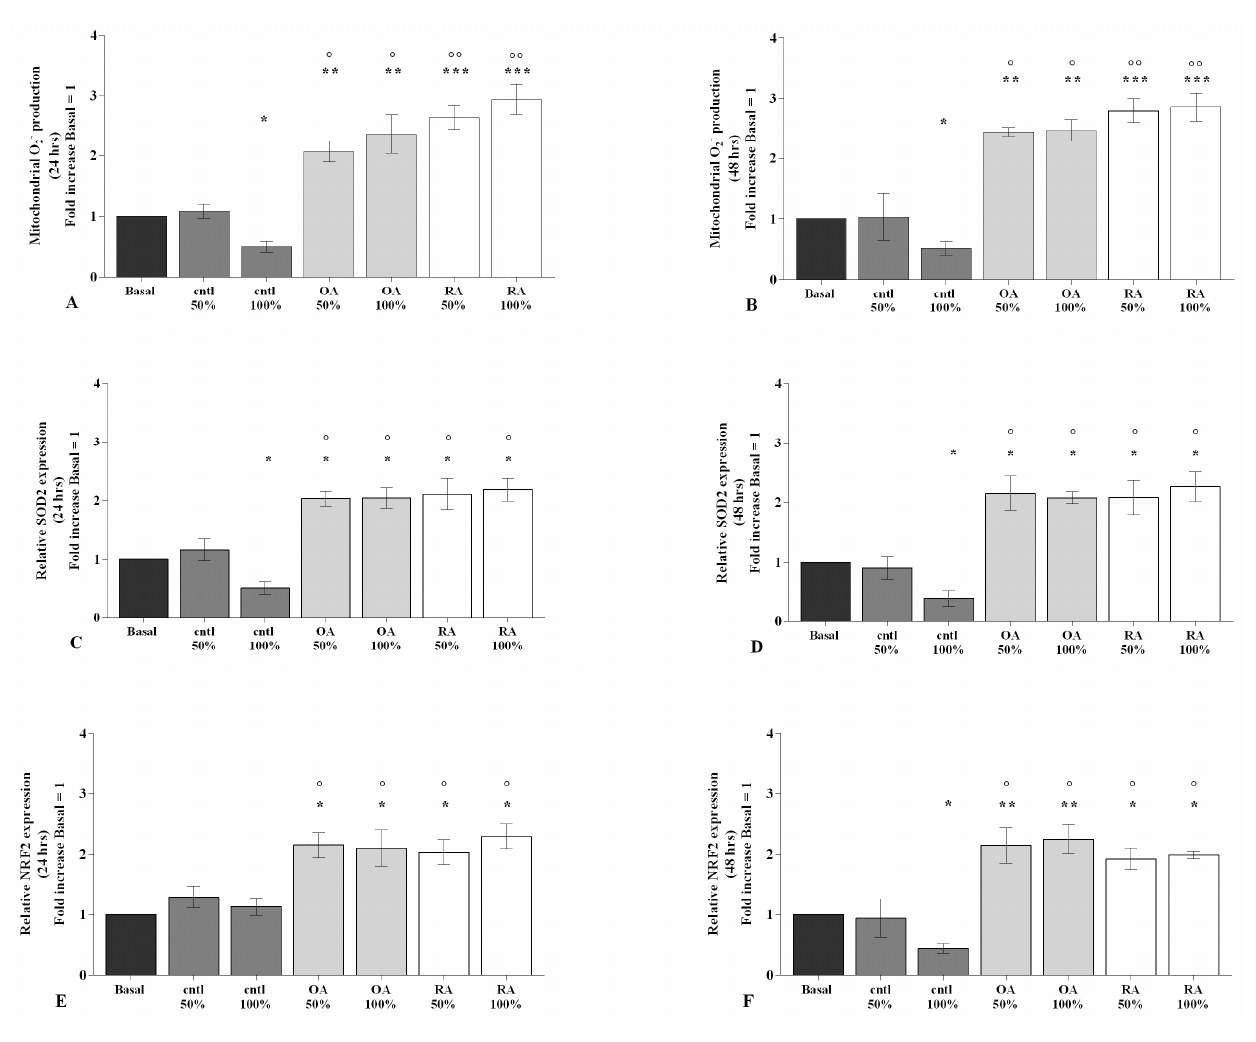
Figure 4. SF modulates oxidative stress balance. Human osteoarthritic (OA) chondrocytes were incubated for 24 h and 48 h with 50% and 100% SF derived from patients with OA, rheumatoid arthritis (RA), or controls. ( A , B ) Mitochondrial superoxide anion production evaluated by MitoSox Red staining at flow cytometry. ( C – F ) Expression levels of superoxide dismutase ( SOD ) -2 and nuclear factor erythroid-derived 2-like 2 ( NRF2 ) analyzed by quantitative real-time PCR. The production of superoxide anion and the gene expression were referenced to the ratio of the value of interest and the value of basal condition, reported equal to 1. Data were represented as mean ± SD of triplicate values. * p < 0.05, ** p < 0.01, *** p < 0.001 versus basal condition. ◦ p < 0.05, ◦◦ p < 0.01 versus control